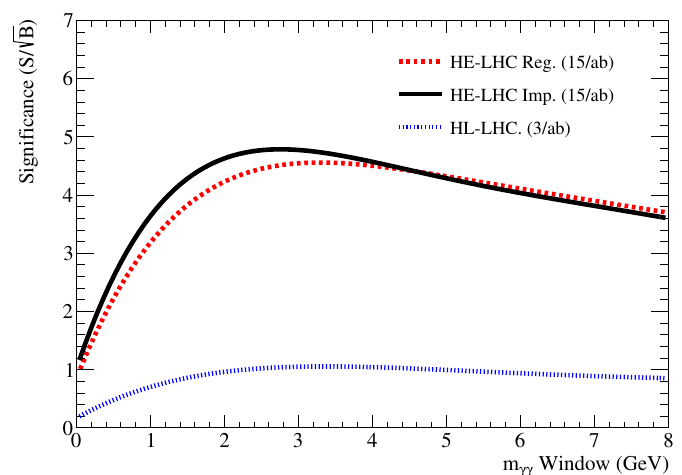
Figure 4. Plot of the expected signi(cid:12)cance ( S= p B ) for each set of signal and background samples as a function of the window on m (cid:13)(cid:13) ( peak of each curve is used to determine the optimal selection cut in each